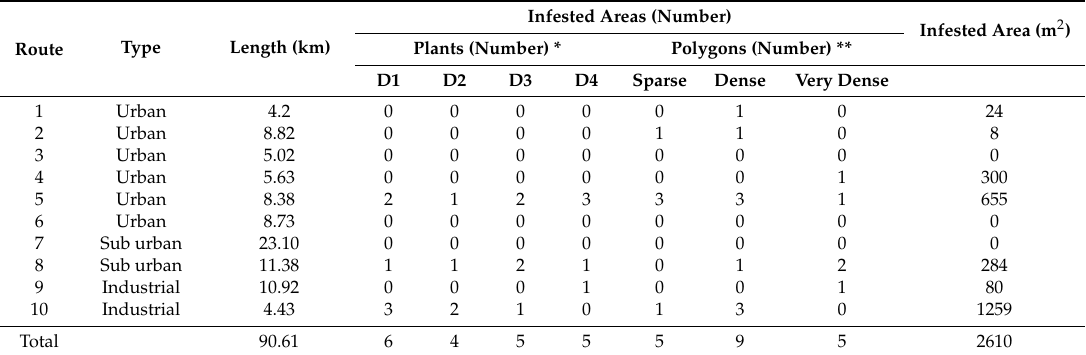
Table 1. Route descriptions and infestation